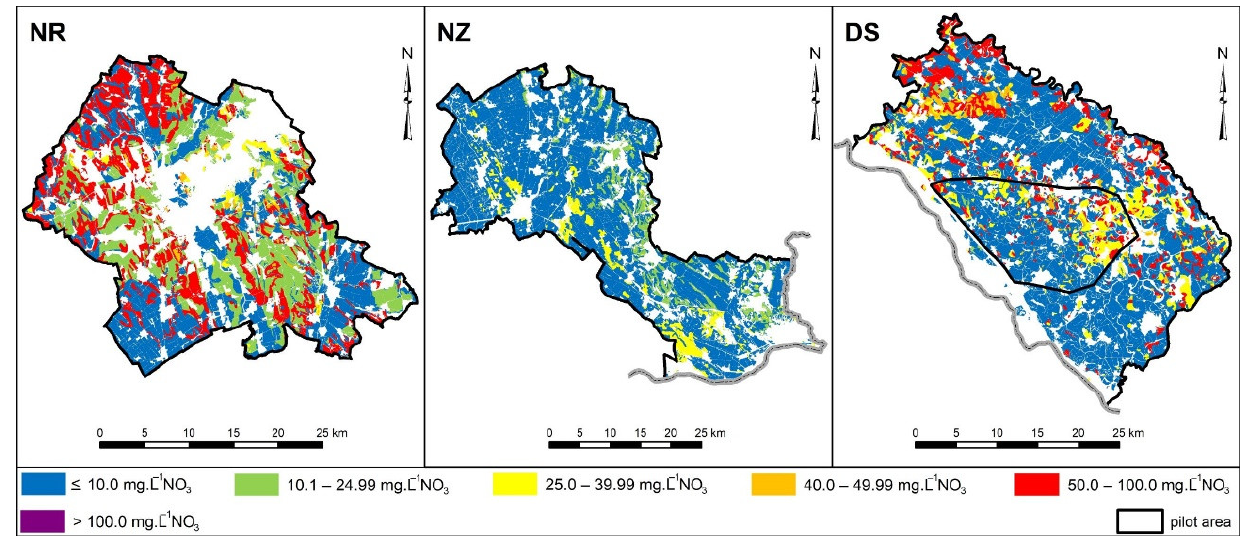
Figure 8. Mean annual nitrates concentration in leachate.